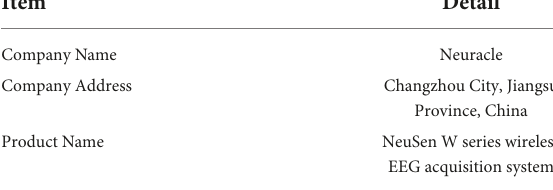
TABLE 2 Details of electroencephalogram (EEG)